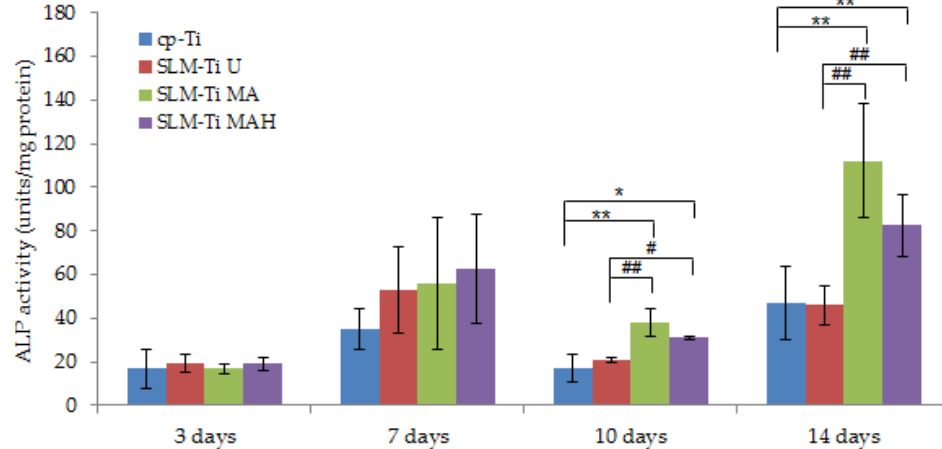
Figure 8. Alp activity of cells on SLM-Ti compared to the cp-Ti control after 3, 10, and 14 days. All values are presented as the mean ± sd (n = 6), * different from cp-Ti at * p < 0.05, ** p < 0.01; # different from SLM-Ti U at # p < 0.05, ## p < 0.01.